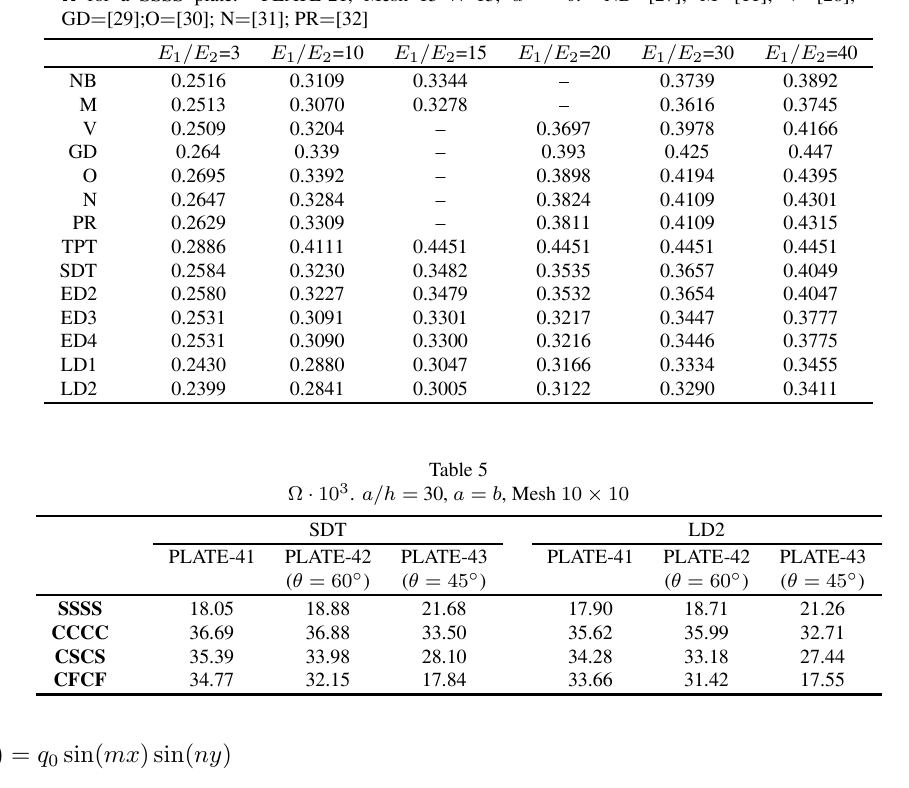
Table 4 Ω for a SSSS plate. PLATE-21, Mesh 15 × 15, a = b . NB = [27]; M = [11]; V =